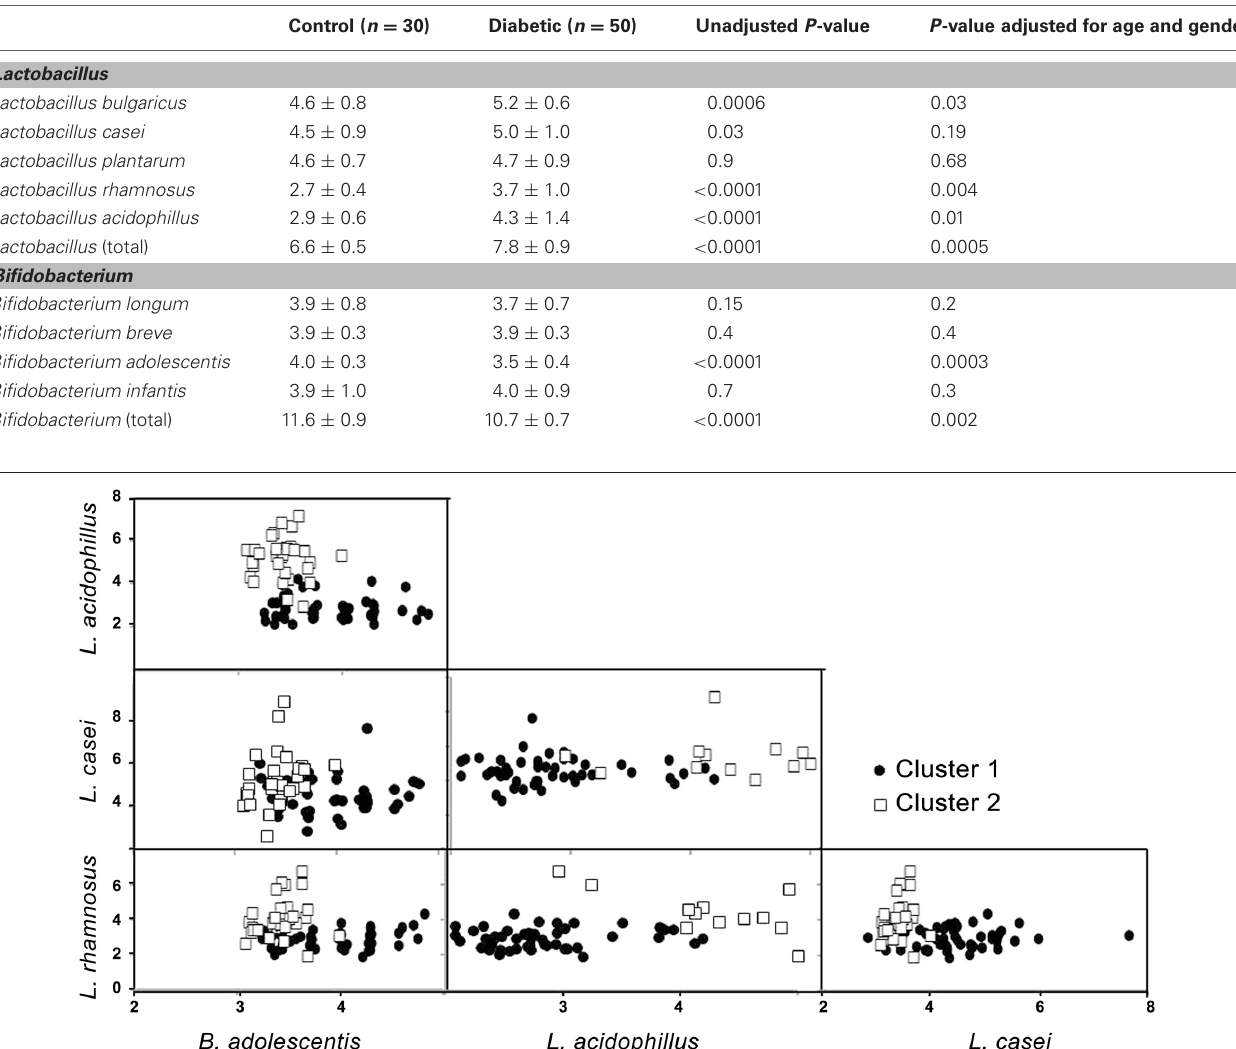
Table 3 | Comparisons of bacteria amounts between controls and diabetic patients (bacterial values transformed using logarithm). Control ( n = 30) Diabetic ( n = 50) Unadjusted P -value P -value adjusted for age and gender